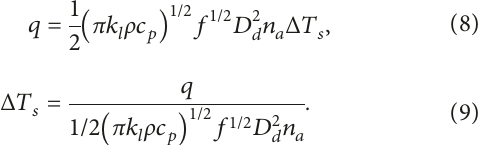
(c) Figure 4: Static contact angles of pure water on stainless steel plates for (a) 200 ° C, (b) 500 ° C, (c) 700 ° C, and (d) 800 ° C. Table 1: Contact angle and thickness of various coated surfaces. Case Contact angle ( ° C) Bare plate 88.4 20 minute with 0.5% nanofluid